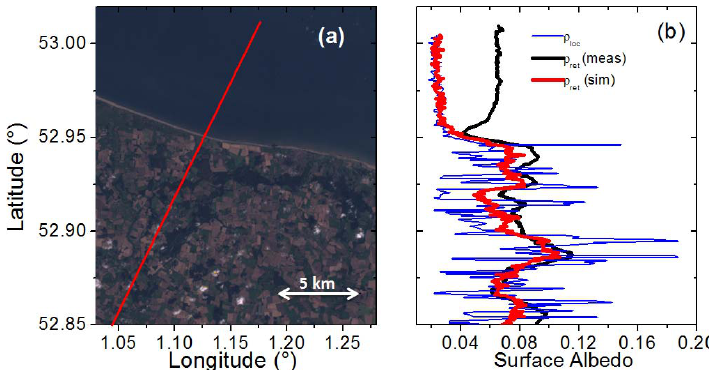
Fig. 8. (a) Landsat image and flight track of the studied area over East Anglia; (b) retrieved area-averaged surface albedo from simulations and local surface albedo taken from Landsat at 660nm along the flight leg. Additionally, the retrieved area-averaged surface albedo from aircraft measurements is